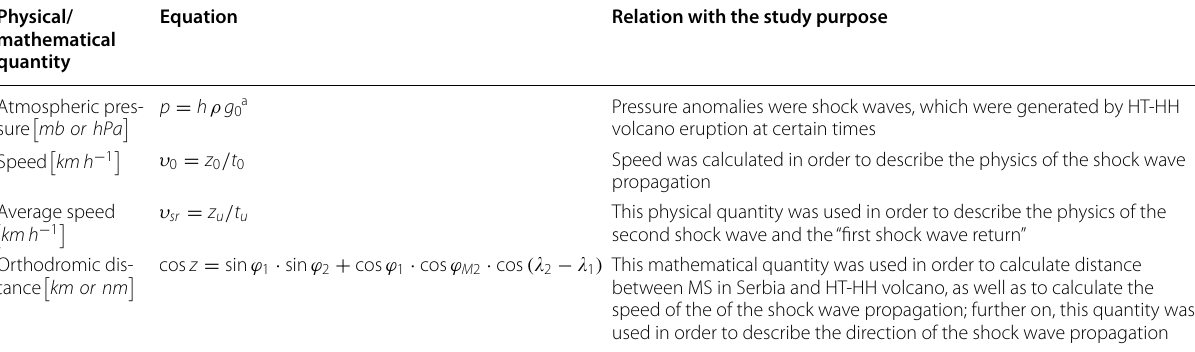
Table 2 Description of the physical and mathematical quantities of the data used in the study and their relation with the study